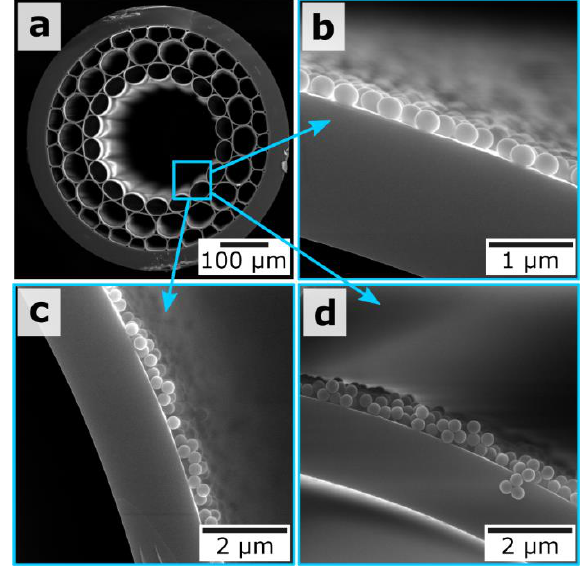
Figure 10. ( a ) SEM image of the MOW end face; ( b – d ) magnified SEM images of the capillaries with one, two, and three deposited layers of 300-nm silica particles, respectively.